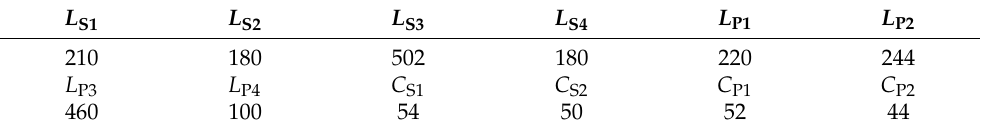
Figure 4. Test environment of reflectionless band-pass filter. The network analyzer and probe